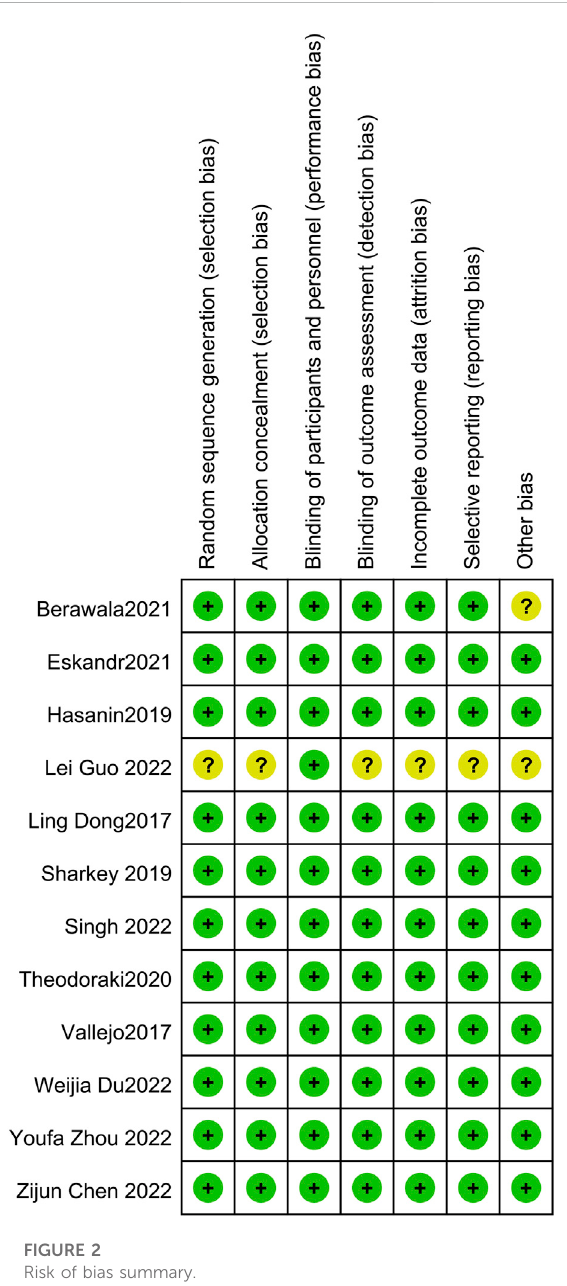
FIGURE 2 Risk of bias